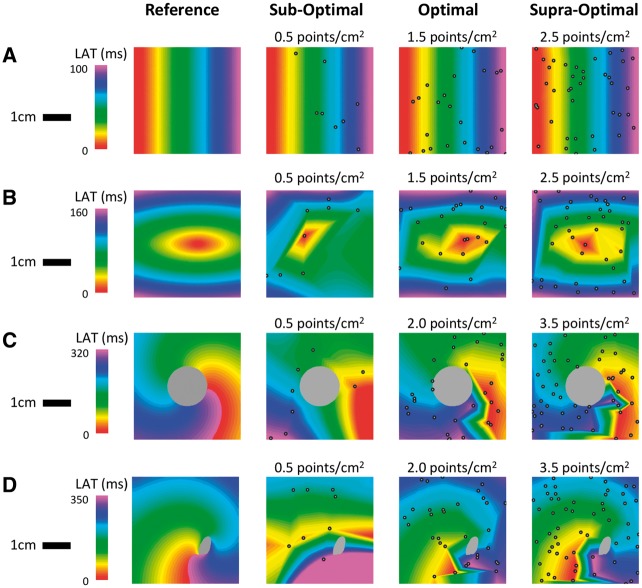
Simulated isochronal local activation time maps. (A) Linear activation; (B) focal activation; (C) re-entrant activation; and (D) spiral wave activation. Reference LAT maps are shown in the left most column. In A and B, local activation time is taken as the first activation of each node. In C and D, a window of interest (WOI) incorporating 100% of the tachycardia cycle length (TCL) was specified. Grey colour represents tissue that is never activated during the WOI—either non-conducting (C) or functionally refractory (D).